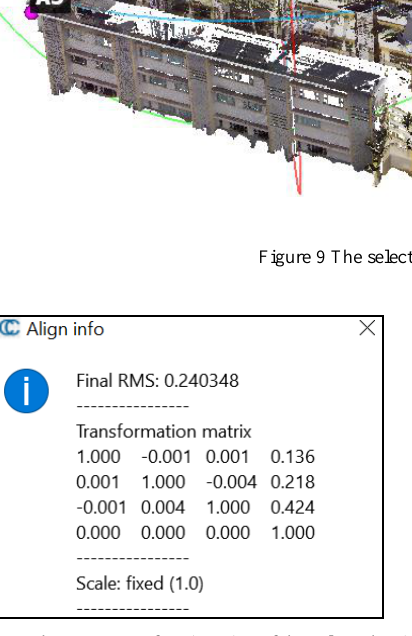
Figure 10 The accuracy of registration of the selected points